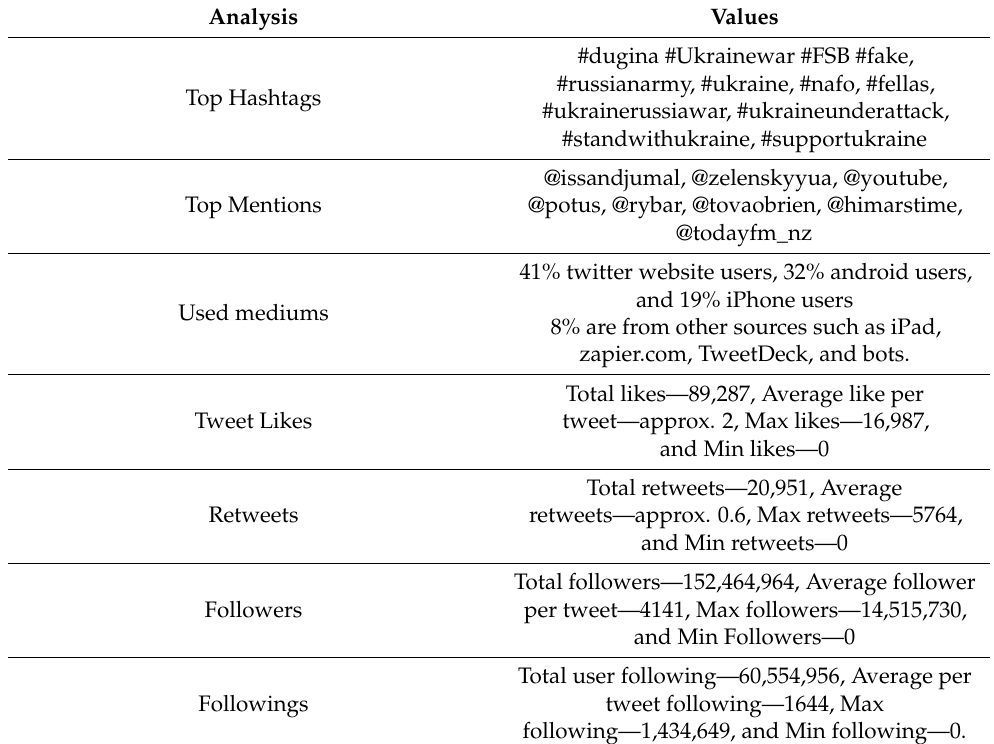
Table 1. Distinct analysis of collected RUW tweets.